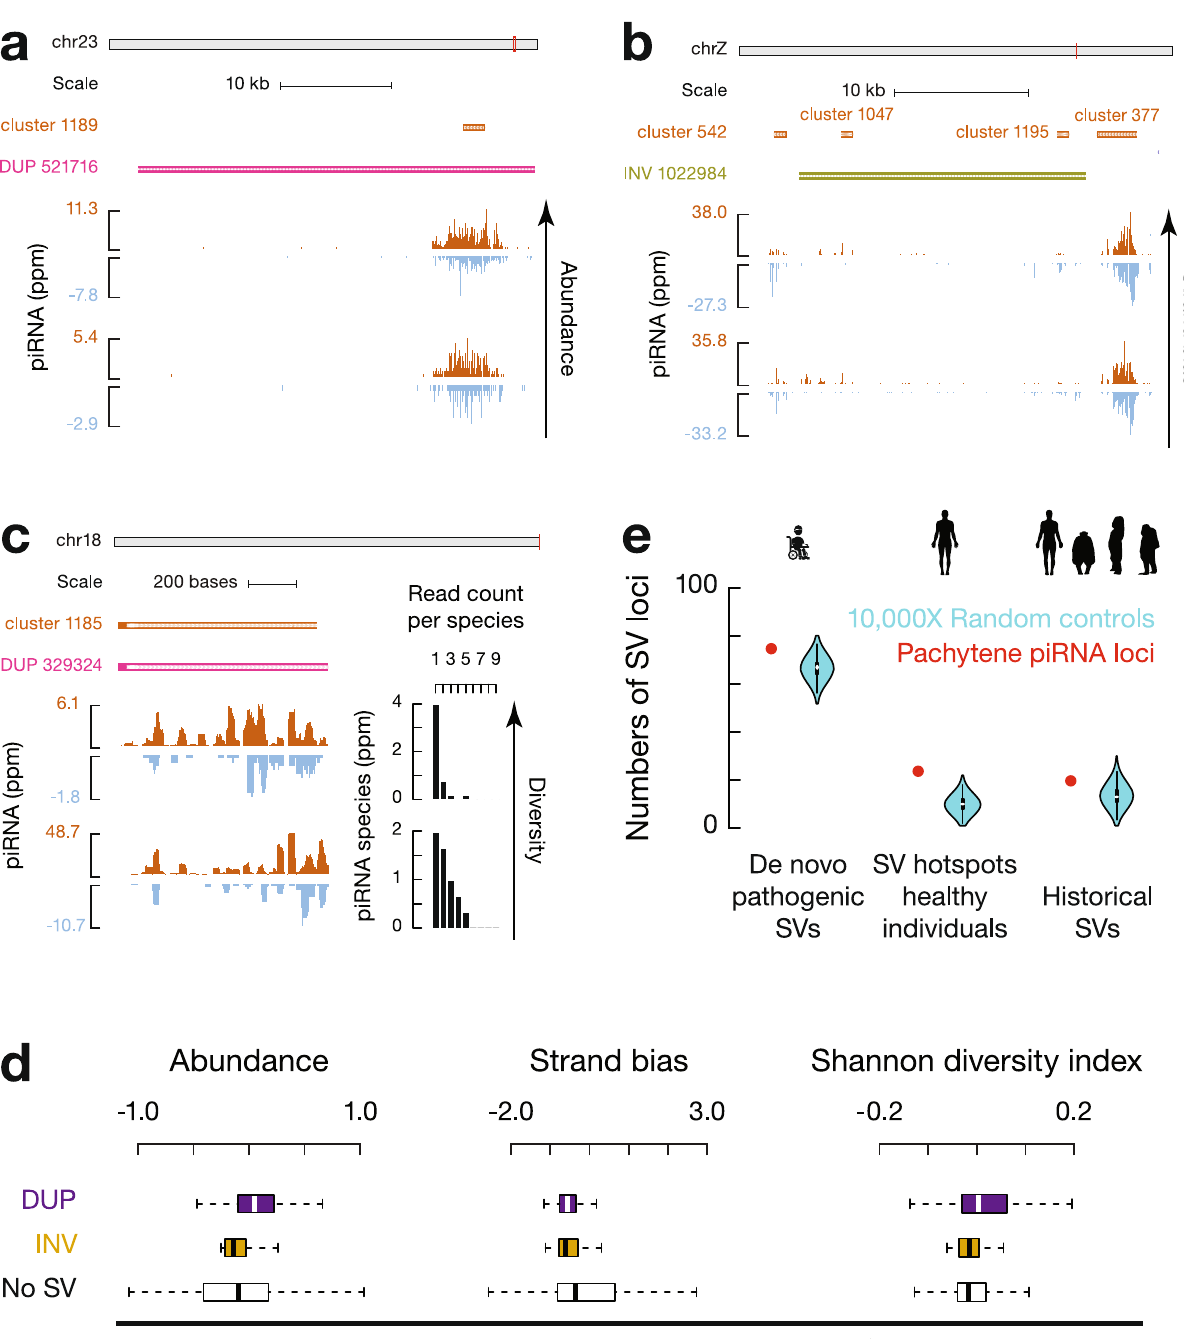
speciesabundancefromthetwochickenindividualsthathavereadcountsof1to9. d Box plots of piRNA variance of Abundance (left), Strand bias (middle), and Shannon diversity index (right) among 23 chickens from 6 breeds. Box plots show the 25thand 75thpercentiles, whiskersrepresentthe 5th and 95th percentiles,and midlines show medianvalues. e Numberofhuman pachytene piRNA loci (red)and randomly shuf fl ed control sequences (aquamarine) overlapping with SV hotspots within de novo pathogenic SVs detected in patients (left), healthy human popula- tions (middle), and historical SVs in the common ancestor of humans and great apes (right). Violin plots represent the medians of randomly shuf fl ed control sequences that were computed 10,000